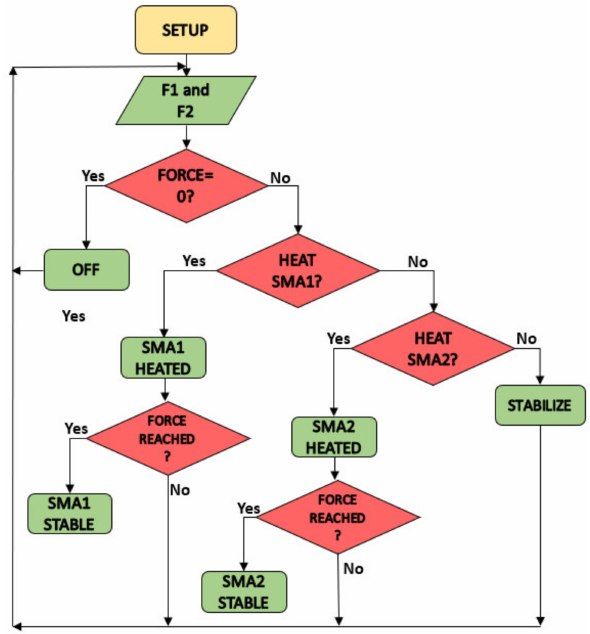
Figure 9. Code flow diagram in